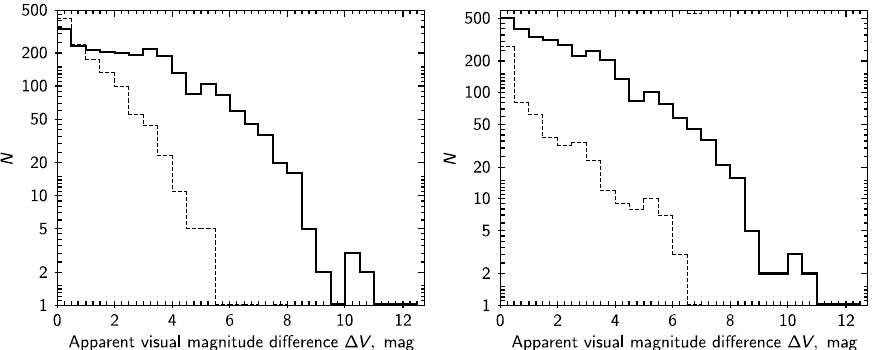
Fig. 6. Distributions of the difference in magnitudes of the components, ∆ V , in the refined set of 3676 pairs. The left-hand panel shows the distribution for pairs with (cid:26) > 1 arcsec (the solid line; the distribution is almost flat (no dependence) at ∆ V < 4 : 0 mag) and for those with (cid:26) < 1 arcsec (the dashed line; the dependence is strong for all ∆ V ). The right-hand panel shows the distribution for stars with V 1 < 9 : 5 mag (the solid line; the distribution is almost flat (no dependence) at ∆ V < 4 : 0 mag) and for those with V 1 > 9 : 5 mag (the dashed line, there is no unbiased ∆ V domain.)